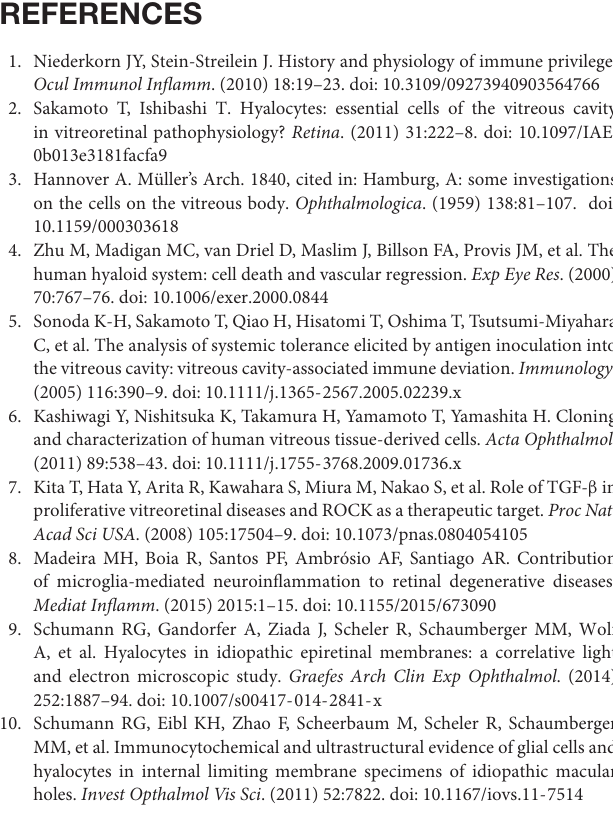
FIGURE S2 | Hyalocytes express numerous leucocyte-associated transcripts. Box plots, illustrating the normalized reads count PTPRC (CD45), ITGAL (CD11a), CX3CR1 , HLA-DRA , SALL1 , ITGB2 (CD18), HEXB , CD14 , CD68 , FCGR1A (CD64), and ITGAM (CD11b) in hyalocytes (Hy), macrophages (Mac), brain microglia (BrMG), and monocytes (Mono). FIGURE S3 | Hyalocytes express numerous factors involved in vitreous homeostasis. Heatmap depicting the expression of genes coding for extracellular matrix proteins in hyalocytes (Hy) and microglia (BrMG). The transcripts are sorted according to the normalized counts (log2-scaled). Significance level for the comparison is shown in the bar on the right side, red coding for a significantly higher expression in human hyalocytes. FIGURE S4 | Biological processes and molecular functions of human hyalocytes. All top expressed genes enriched in the 5 most disease-relevant GO biological processes (BP, A ) and molecular functions (MF, B ) terms are illustrated in cnetplots. FIGURE S5 | Negative controls for immunohistochemistry. Negative controls were performed by omitting primary antibodies. (A) Negative control for FTL and CD74 immunohistochemical stainings shown in Figures 2D,E . Nuclei are counterstained with DAPI. GAR647, goat anti-rabbit Alexa Fluor 647. (B) Negative control for HLA-DRA and IBA1 immunohistochemical staining shown in Figure 3F . Nuclei are counterstained with DAPI. DAM568, donkey anti-mouse Alexa Fluor 568. DAG647, donkey anti-goat Alexa Fluor 647. FIGURE S6 | Immunohistochemical stainings for CD74 (A) and HLA-DRA (B) . The arrows point at vitreal cells positive for CD74 (first and second row in A ) or HLA-DRA (B) . Vitreal cells are presented in higher magnification in the upper right corner (third and fourth row in A ). Nuclei are counterstained with DAPI. DIC, differential interference contrast; GCL, ganglion cell layer; INL, inner nuclear layer; and ONL, outer nuclear